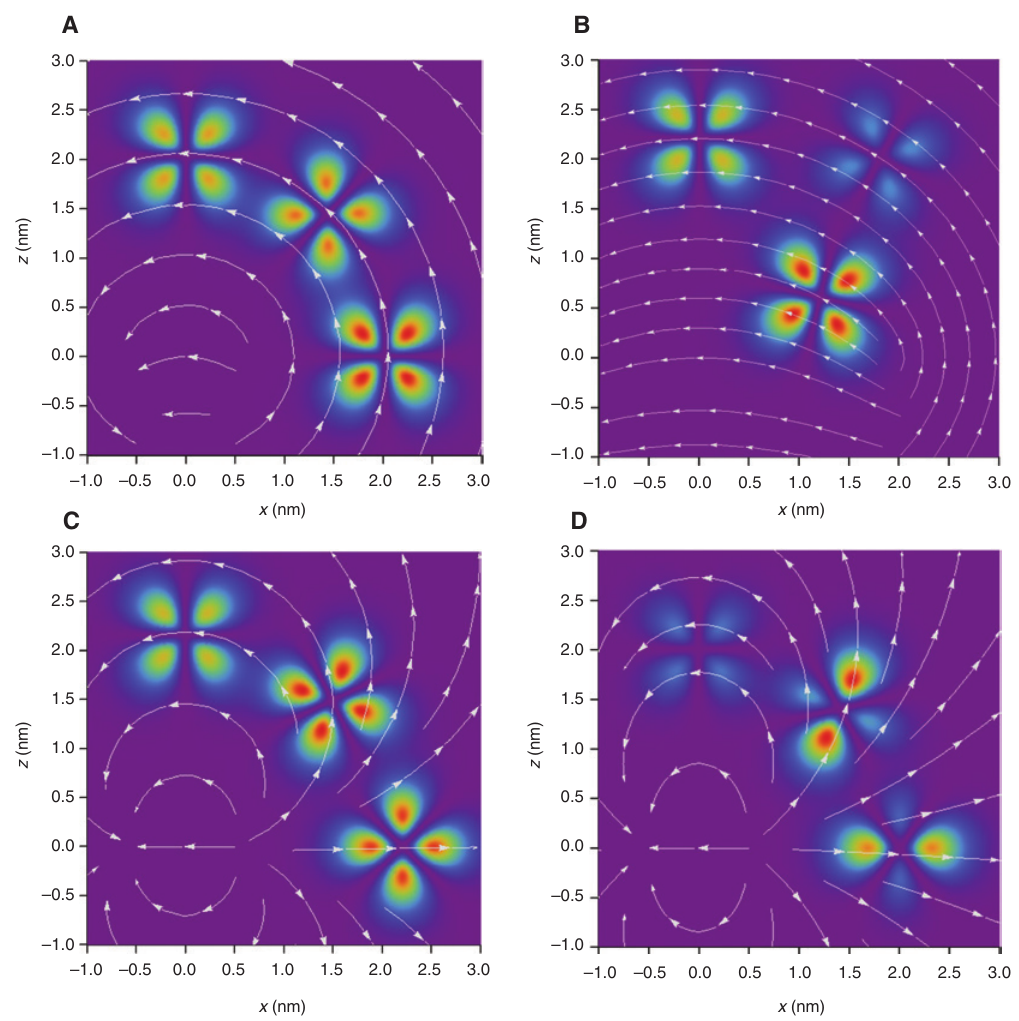
Figure 4: Plot of the xz cross section of the excited state wavefunction as defined in Eq. (6), at strategic locations under various conditions. (A) w = 1 nm with a cylindrical field profile described in Figure 1B, generated by integrating line dipoles from z = − 100 to 0 nm, approximated by Eq. (2). (B) Same as (A) except w = 4 nm. (C) w = 1 nm using the line dipole field of Eq. (1), depicted in Figure 1A. (D) Excited state wavefunc- tions with a point dipole source. Unlike those excited by the infinite line sources, the wavefunctions are not of a uniform